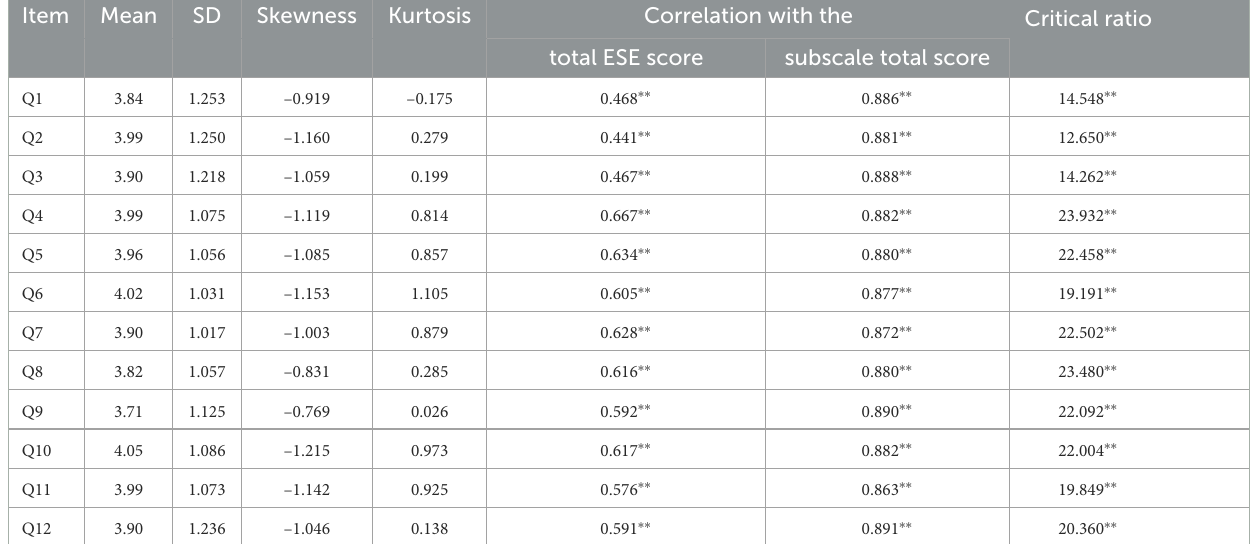
TABLE 2 Mean, standard deviation, Pearson correlation with the total ESE score and critical ratio of the ESE-scale items ( N =